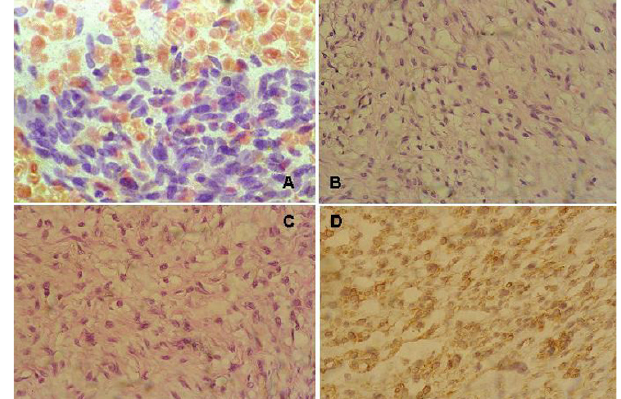
cell lipoma Figure 1 spindle cell lipoma . (a) Benign cytology BSCT, moderately cellular smear with benign looking spindle cells, Papanicolaou × 400. (b) Bland spindle cells intermingled with mature adi- pocytes and thick collagen bundles, H&E × 400. (c) Another field of the same case where the adipocytes are less promi- nent compared to "b", H&E × 400. (d) Adipocytes and spin- dle cells positive for CD34 IHC, DAB, Hx, × 400. See additional files 1, 2, 3, 4 for higher resolution